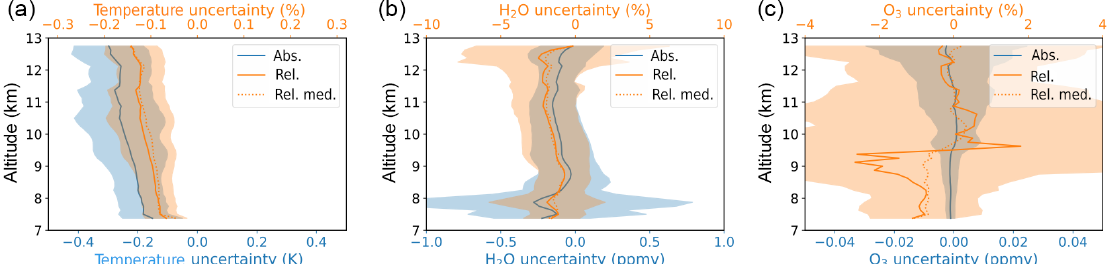
Figure 12. Absolute (blue) and relative (orange) differences between original and perturbed retrieval results for temperature (a) , water vapor (b) , and ozone (c) . Solid lines show the mean differences over the whole flight, the dotted orange line shows the relative median, and the shaded areas show the standard deviation for the 274 evaluated profiles over the